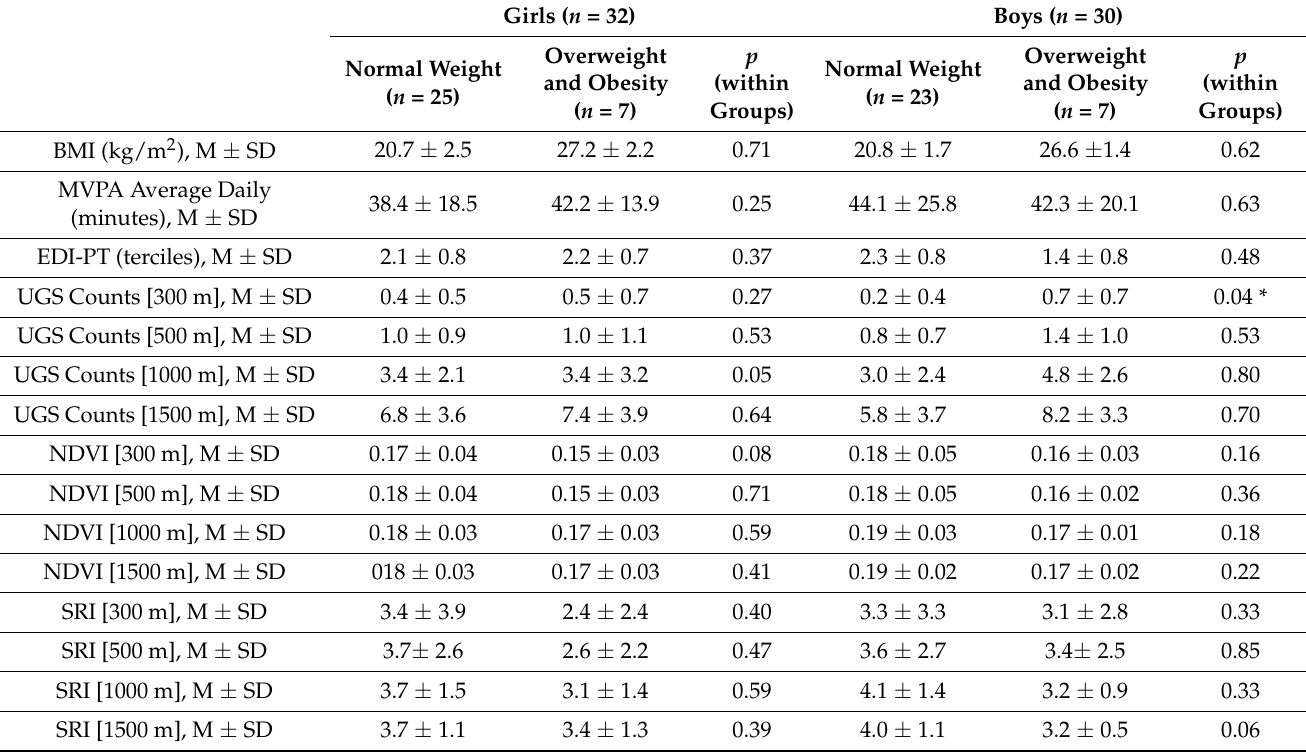
Table 2. Descriptive statistics for each variable by gender and by body mass index categories.